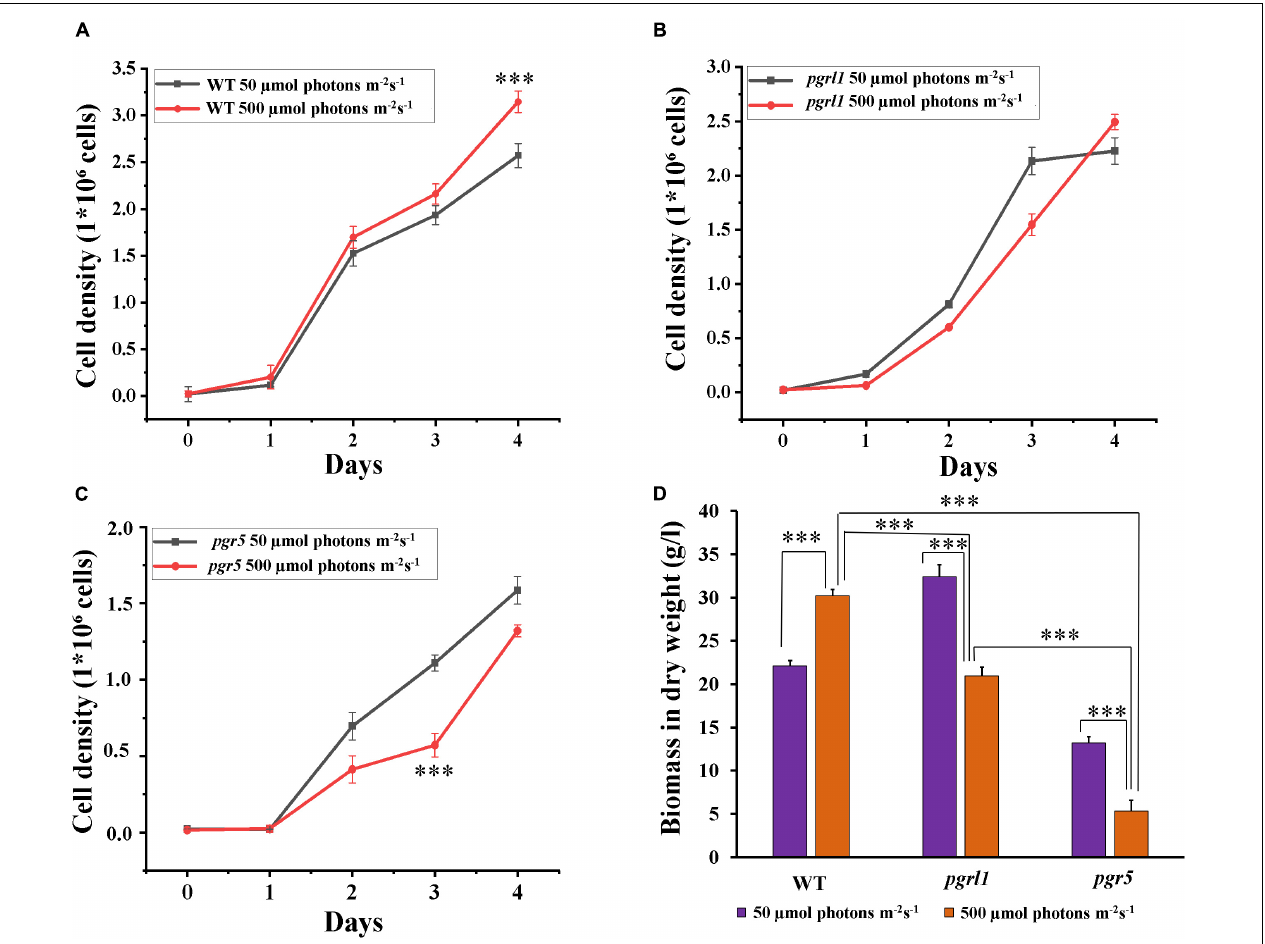
FIGURE 1 | Cell growth and dry biomass were monitored from cells grown under normal light and high light conditions. (A–C) Cell growth was analyzed by cell counting by hemocytometer collected for every 24 h of WT (CC124), (B) , proton gradient regulation 1 ( pgrl1 ), and (C) , proton gradient regulation 5 ( pgr5 )